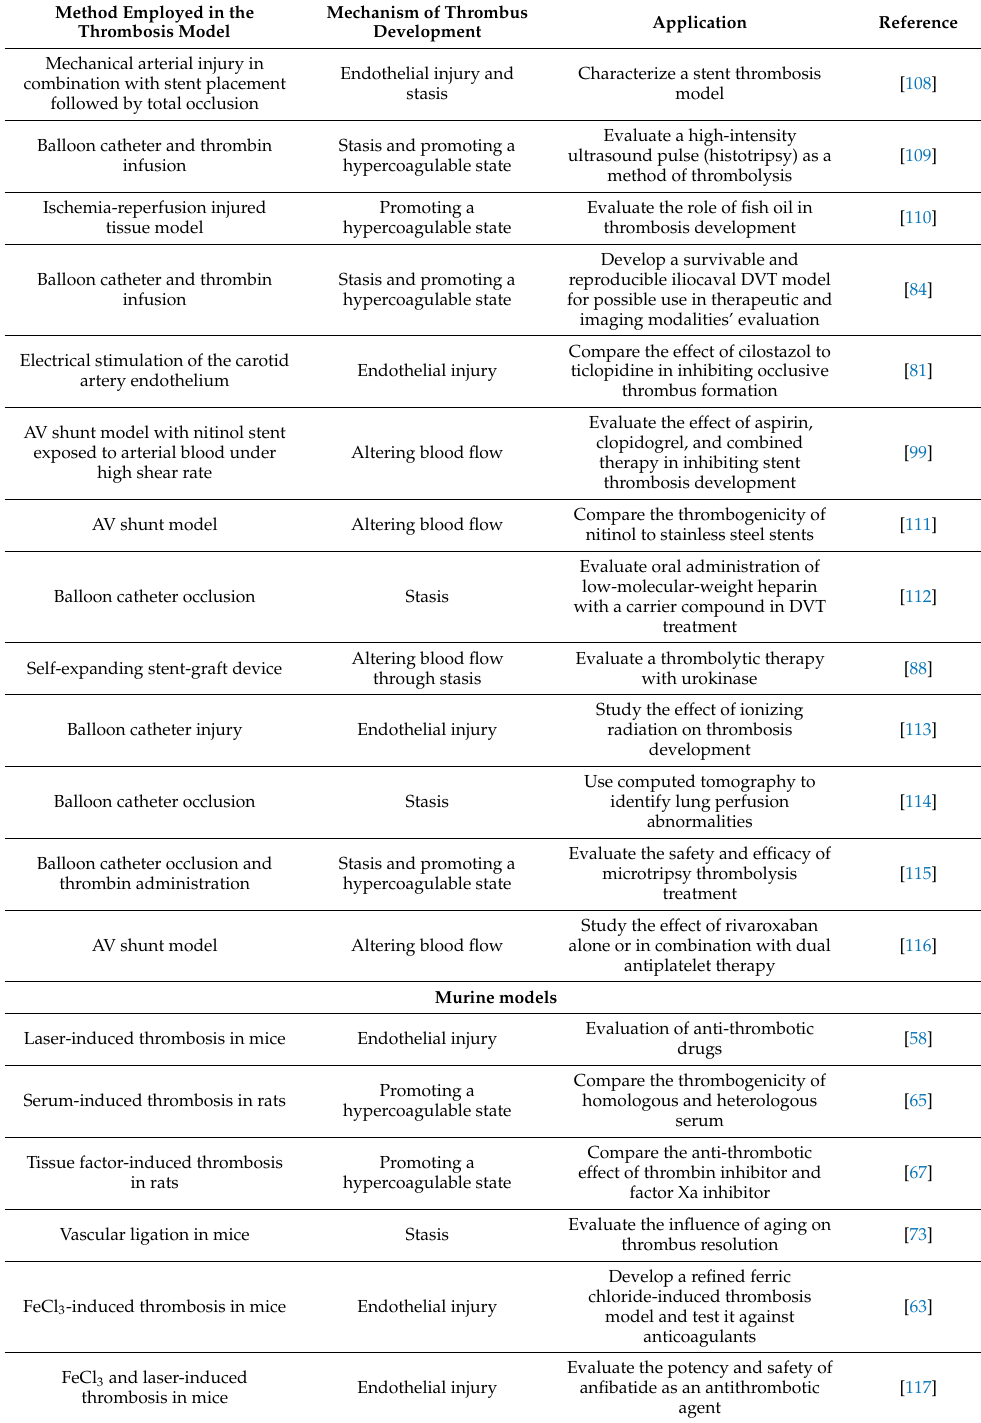
Table 2. Cont. Method Employed in the Thrombosis